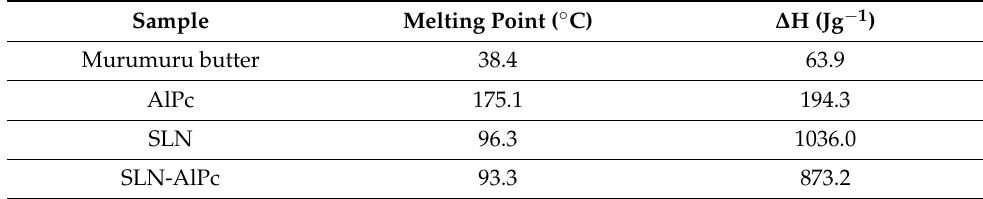
Table 6. Results were obtained with DSC analysis of murumuru butter, AlPc, and SLN.